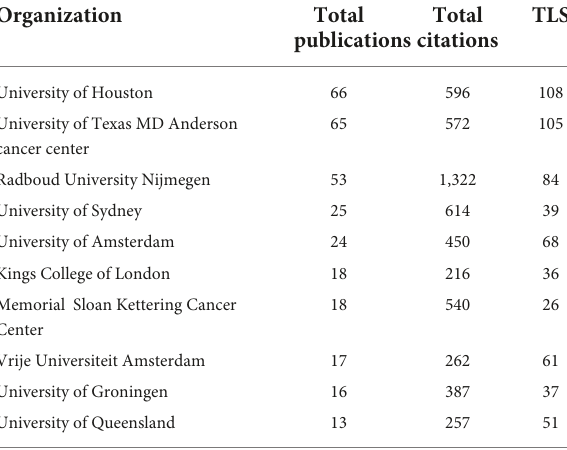
TABLE 2 Top 10 most productive organizations in the research